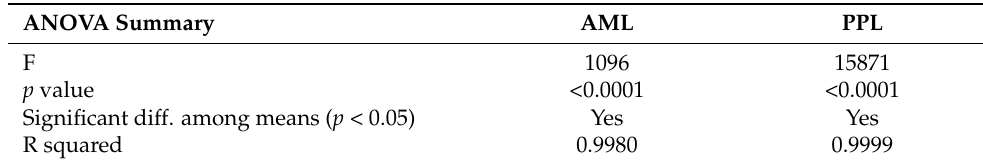
(PPL) with activated carbon samples, from A1 to A13.